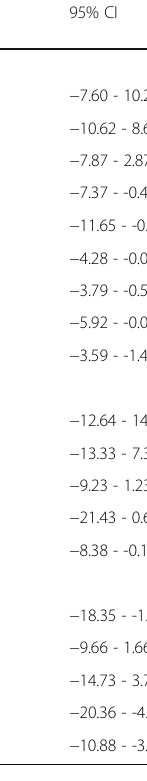
Table 4 Results of the meta-analysis of the change in SBP (mmHg) in the two subgroup analyses of the three groups of sex and age